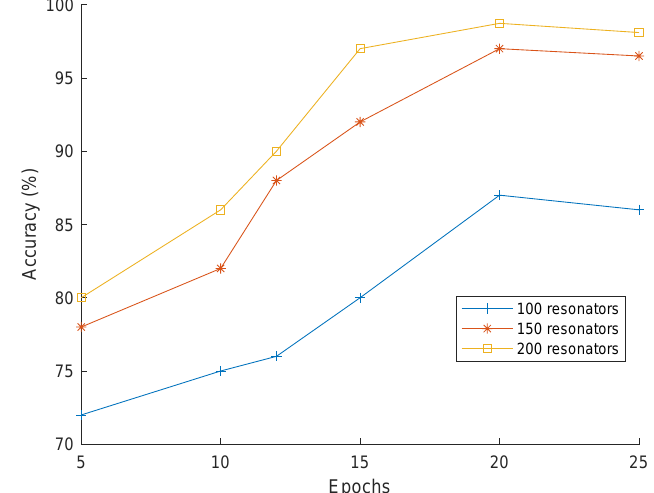
Figure 11. Accuracy as a function of epochs for different numbers of resonators. The classification accuracy is compared with two other existing SNN-based ap- proaches [16,26] using the same RWCP database. Table 1 depicts the accuracy results